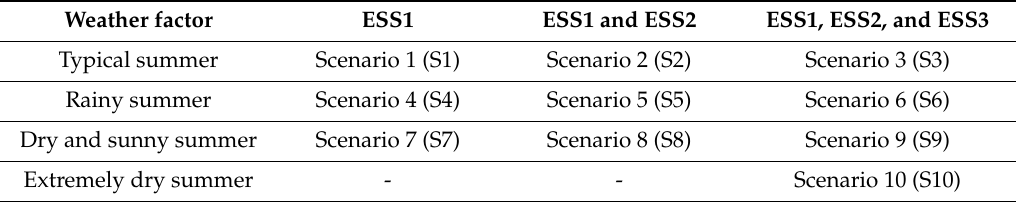
Table 1. Scenarios according to weather and number of batteries in the energy-storage system (ESS).